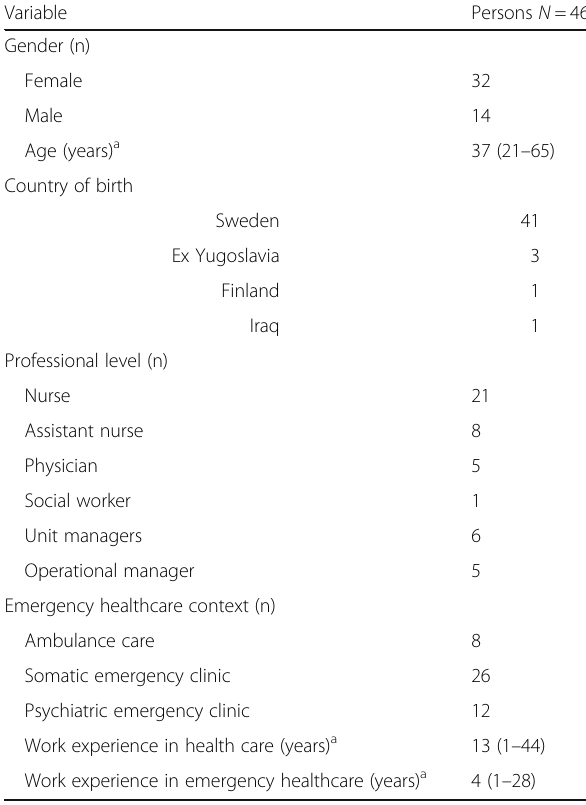
Table 1 Characteristics of the study population